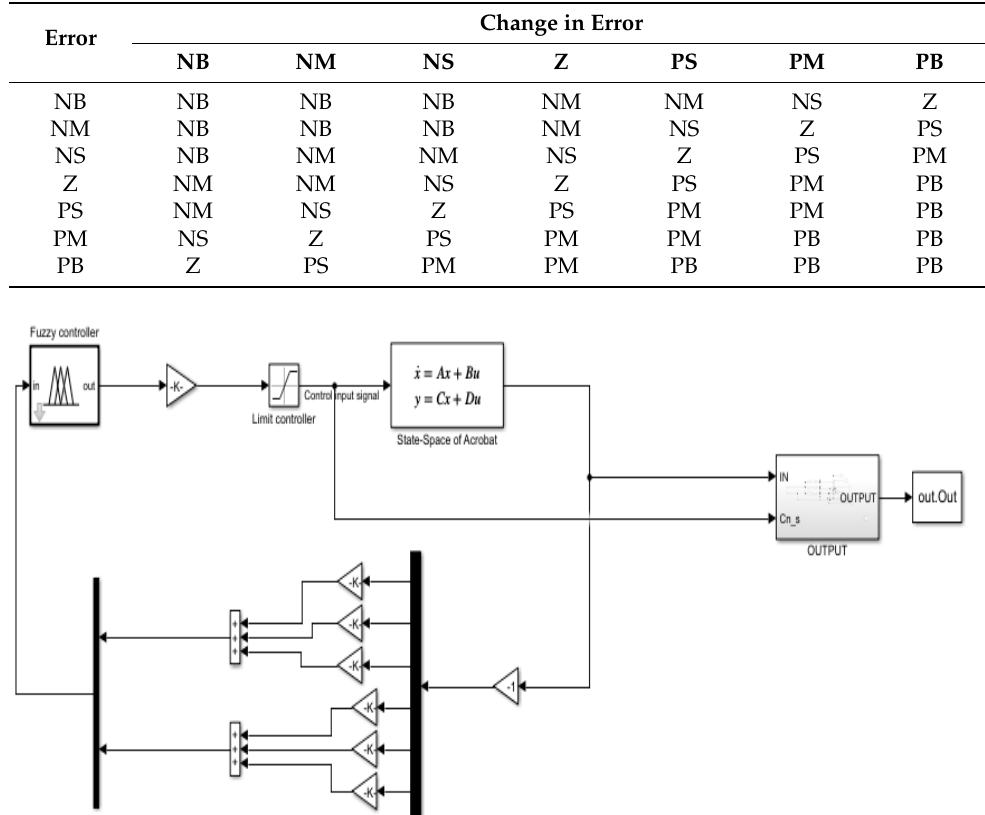
Table 3. Rules of FL controller [18].